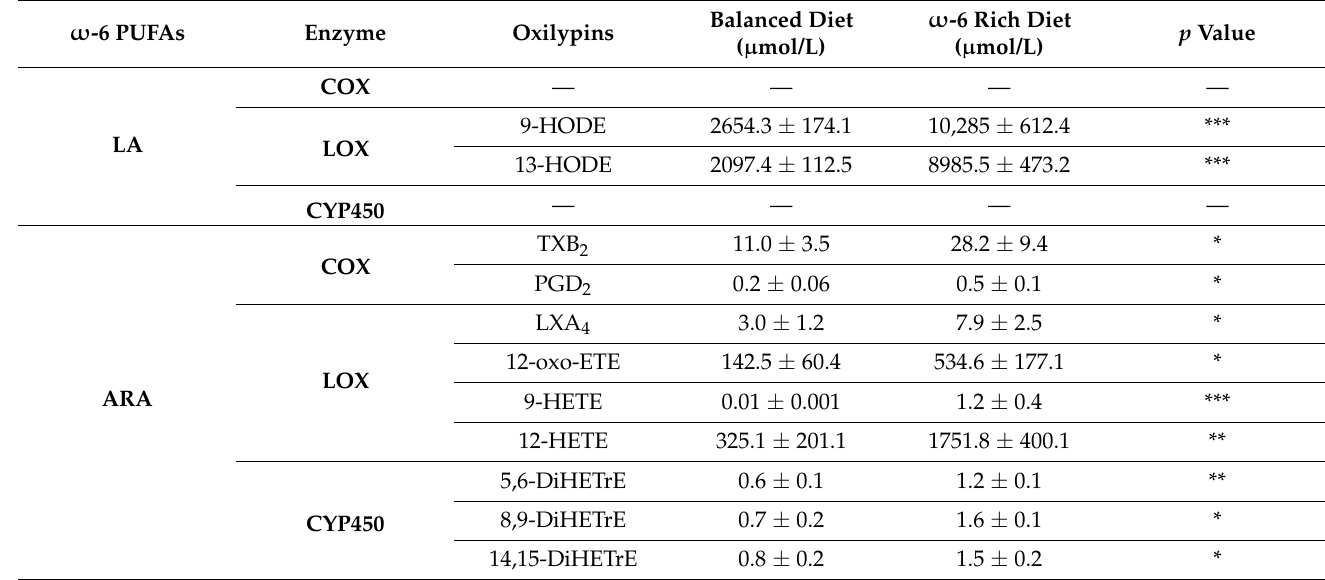
Table 1. ω -6 oxylipins levels in plasma of mice with balanced and ω -6 rich